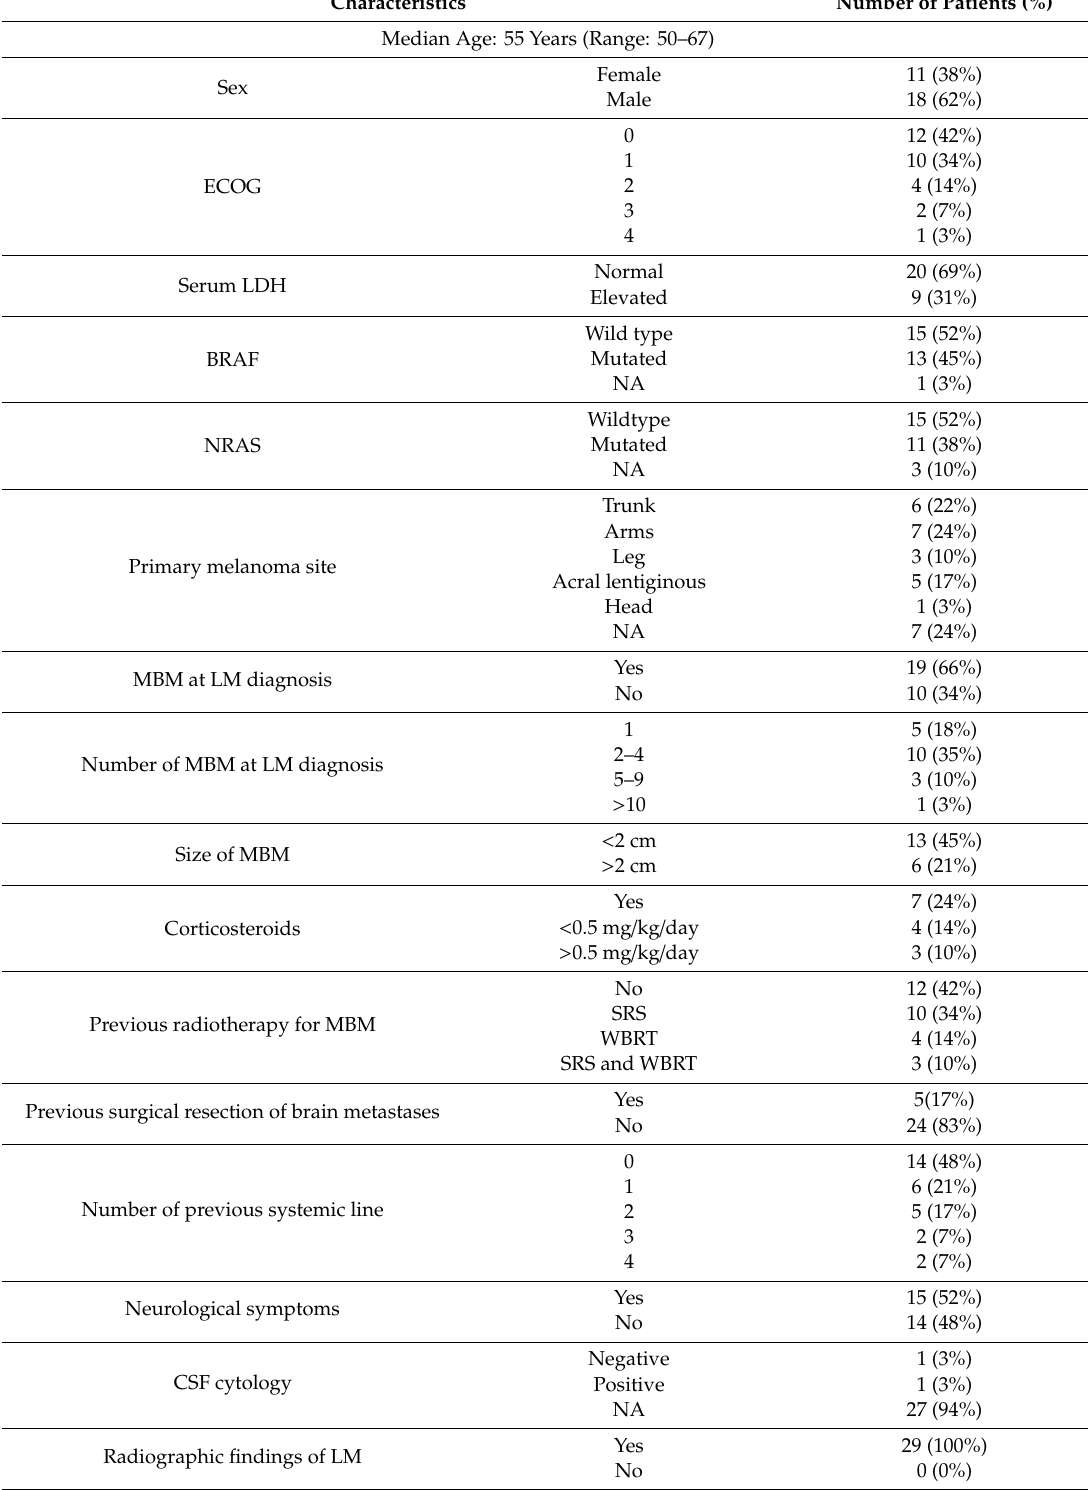
Table 1. Characteristics of melanoma patients at leptomeningeal disease